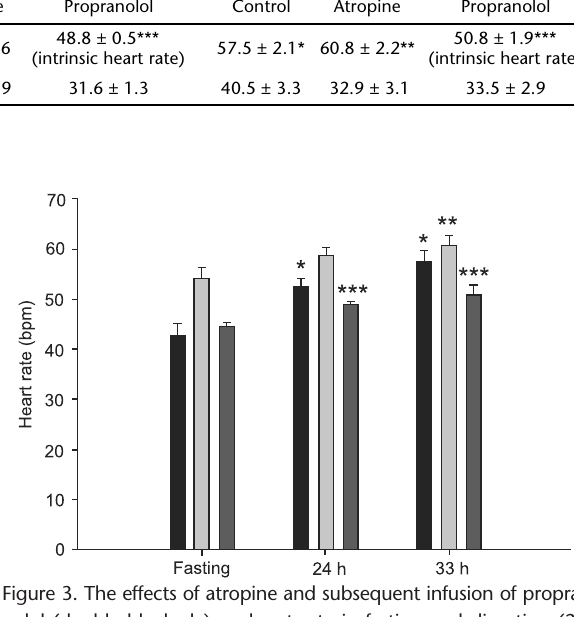
Figure 3. The effects of atropine and subsequent infusion of propra- nolol (double blockade) on heart rate in fasting and digesting (24 and 33 hours) bullfrogs. The double-blocked heart rate measured af- ter propranolol increased significantly during digestion. Asterisk shows significantly differences from fasting values within same drug treat- ment. ( (cid:132) ) Control, ( (cid:132) ) atropine, ( (cid:132) ) propranolol